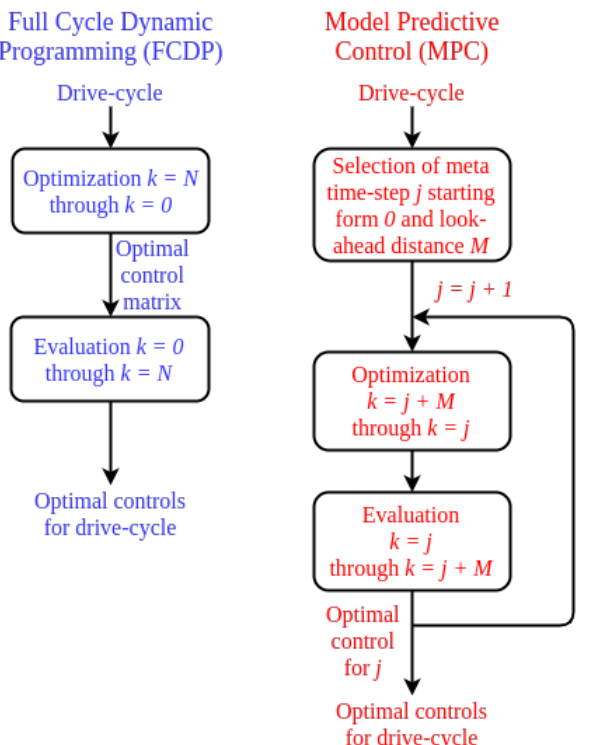
Figure 5. Schematic comparison between the FCDP and MPC